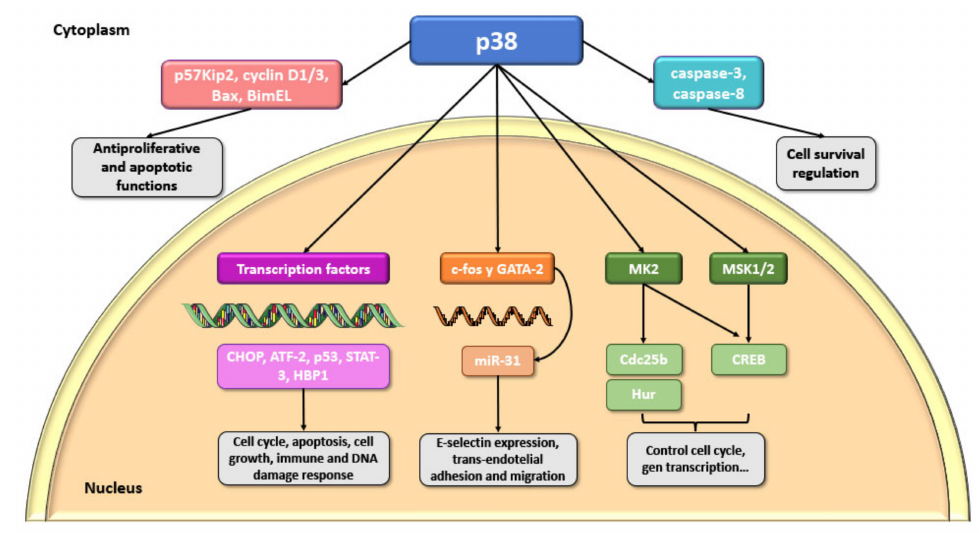
Figure 2. Different substrates and targets of p38 and their related activities. p38 phosphorylates